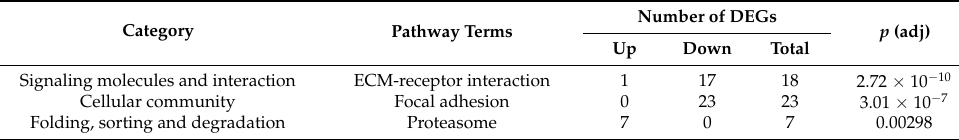
Table 3. KEGG enrichment analysis of DEGs in skin at 14 days post IHNV